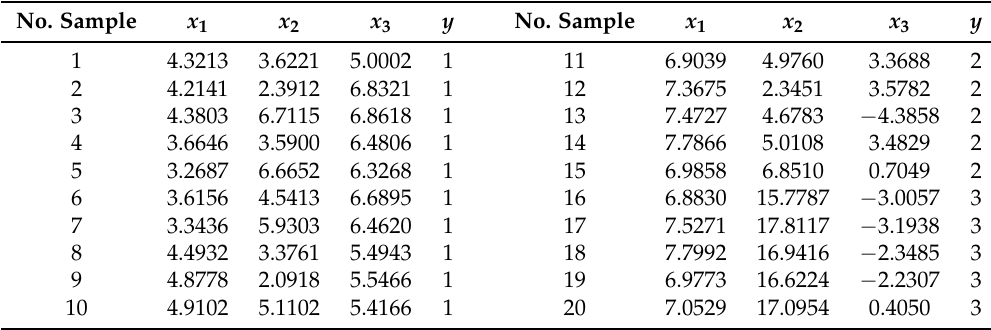
Table A1. Dataset used in the numerical example.